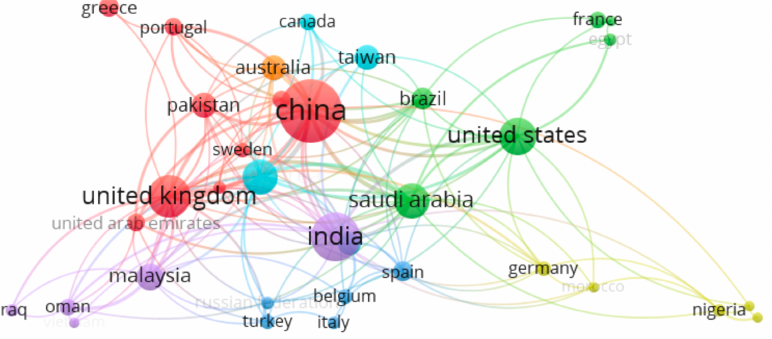
Figure 3. Global distribution and networks related to the articles in this